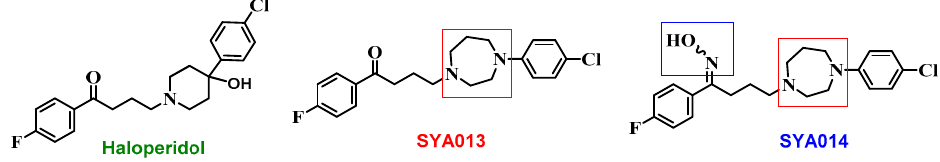
Figure 1. Chemical structures of haloperidol, SYA013, and SYA014.